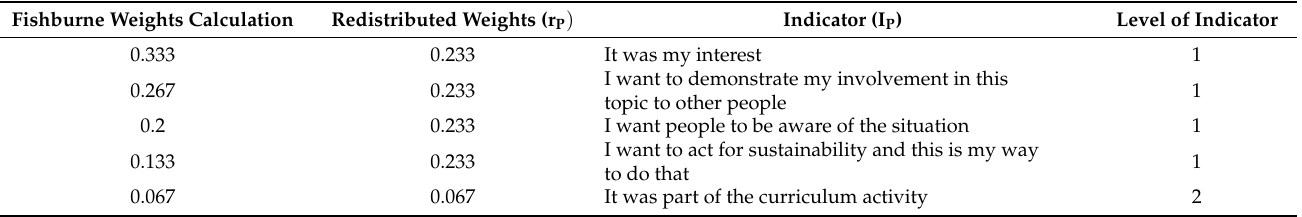
Table 29. Reasoning indicators for participation.